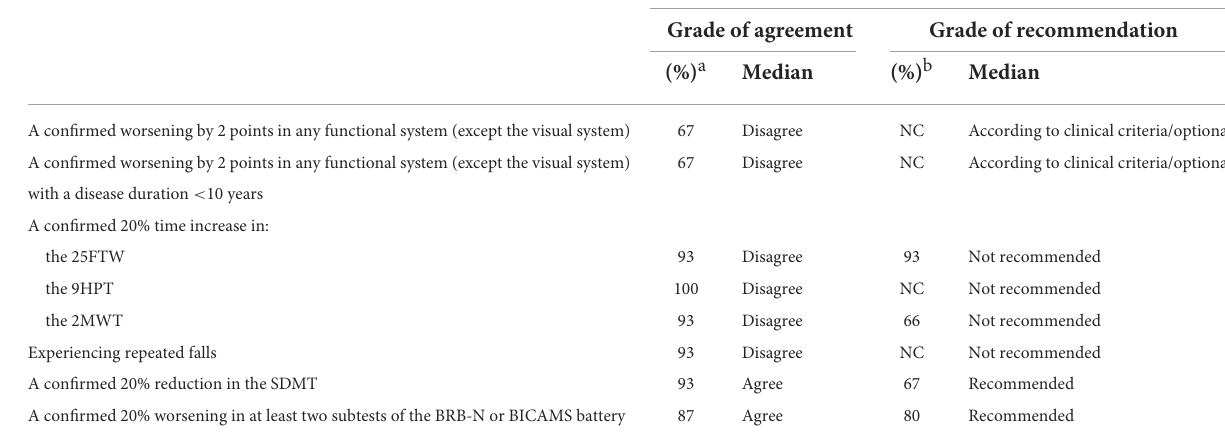
TABLE 2 Variables whose isolated change does not allow diagnosis of progression.